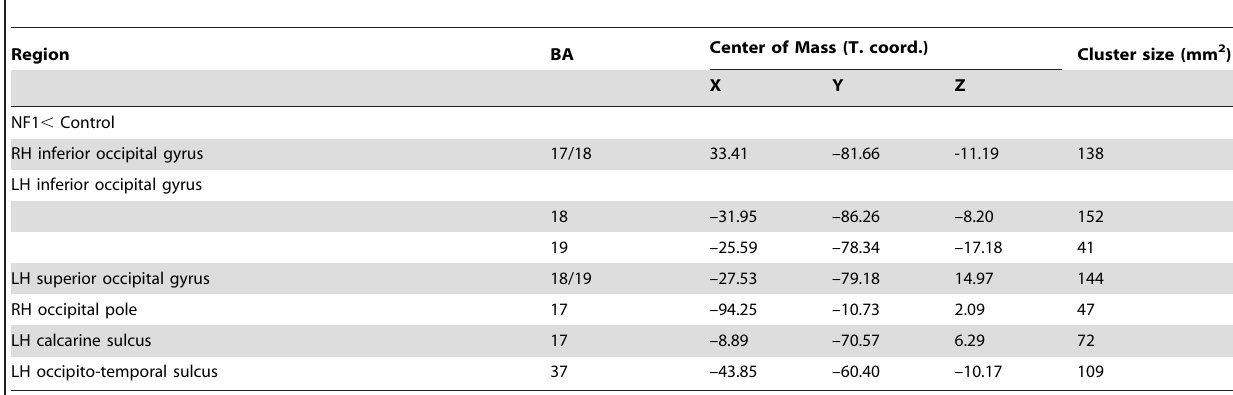
Table 3 Localization and cluster size of the regions with significant between-group differences in activation during P-biased stimulation for the overall (children and adults)